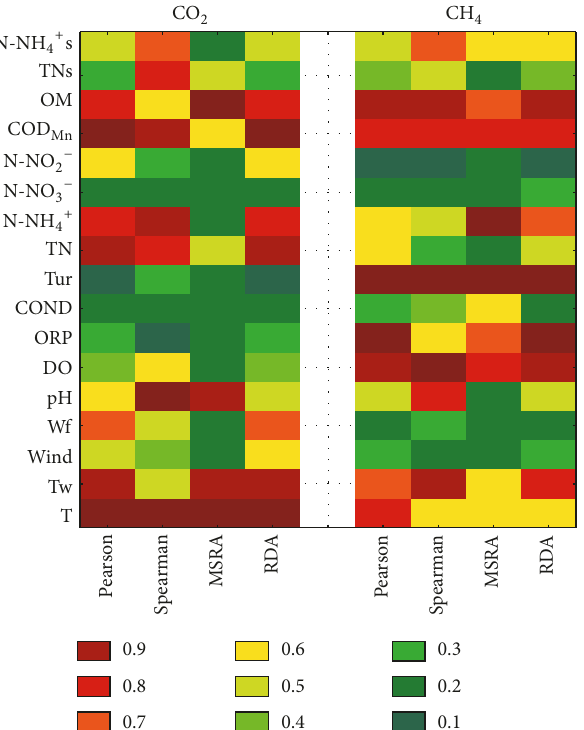
Figure 9: The schematic diagram of identification of environmental factors affecting the fluxes of CO 2 and CH 4 . Pearson and Spear- man: the correlation analysis of Pearson and Spearman; MSRA: multiple stepwise regression analysis; RDA: redundancy analysis; T: atmospheric temperature; Tw: water temperature; wind: wind velocity; Wf: water flow rate; DO: dissolved oxygen; ORP: oxidation- reduction potential; COND: conductance; Tur: turbidity. The color change from green to red shows the increase of importance on the effect of CO 2 and CH 4 fluxes. For the calculation method see Section